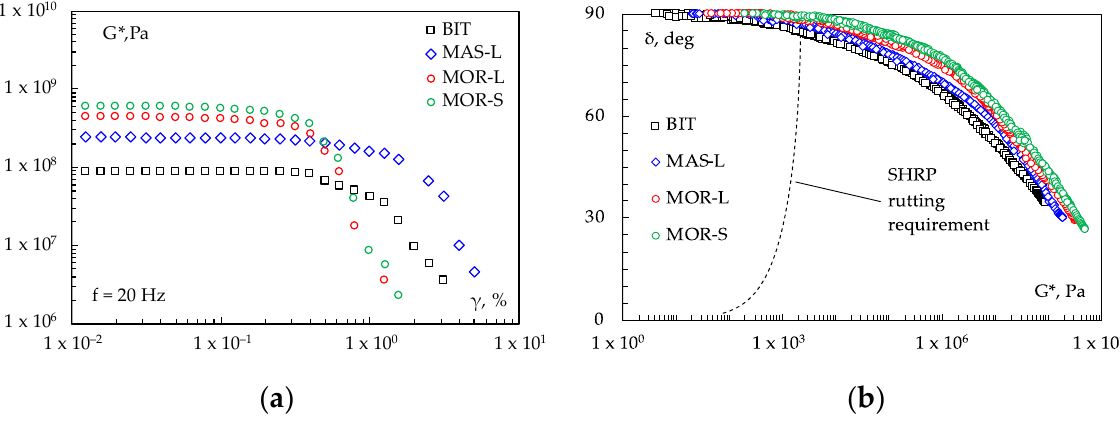
Figure 4. AS and FS results: G* vs. γ for LVE limit study ( a ); Black diagrams δ vs. G* ( b ).